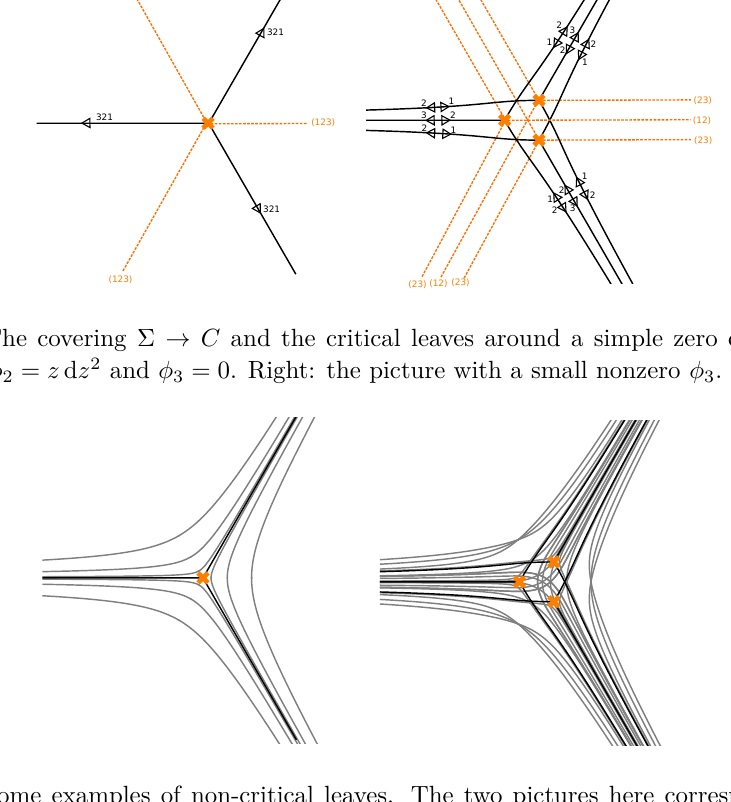
Figure 31 . Some examples of non-critical leaves. The two pictures here correspond to the two pictures in figure 30 above. In the left picture, we only have one foliation. In the right figure, this one foliation has been perturbed into three distinct foliations. Far from the branch points, we have φ 3 (cid:28) φ 2 and the three foliations are close to the single foliation F approx ; near the branch points, the three foliations are far from